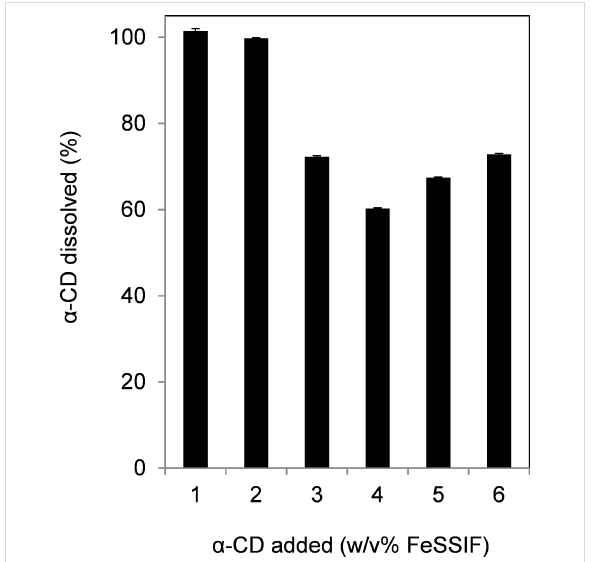
Figure 3: Concentration of α -CD in the FeSSIF. The experimental conditions were the same as those described in the legend to Figure 2. The α -CD content in micelles (%) are given as dissolved α -CD content compared with additional α -CD content. Means and standard errors are indicated ( n =